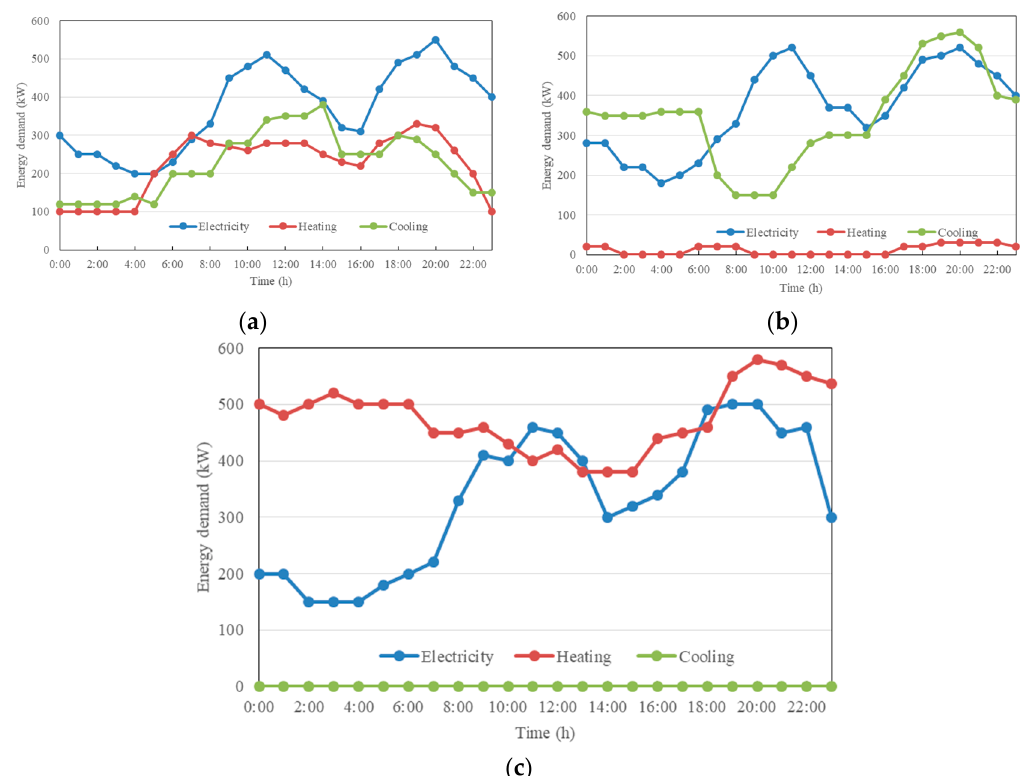
Figure 3. Load profiles of a residential zone in different season: ( a ) transition season; ( b ) summer; ( c ) winter.